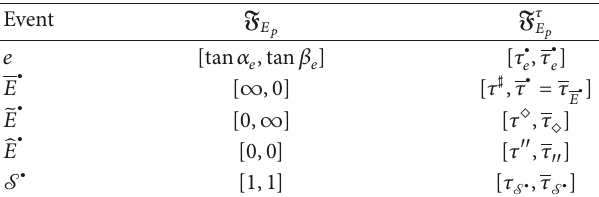
Table 10: The change of projective frame and the corresponding events.